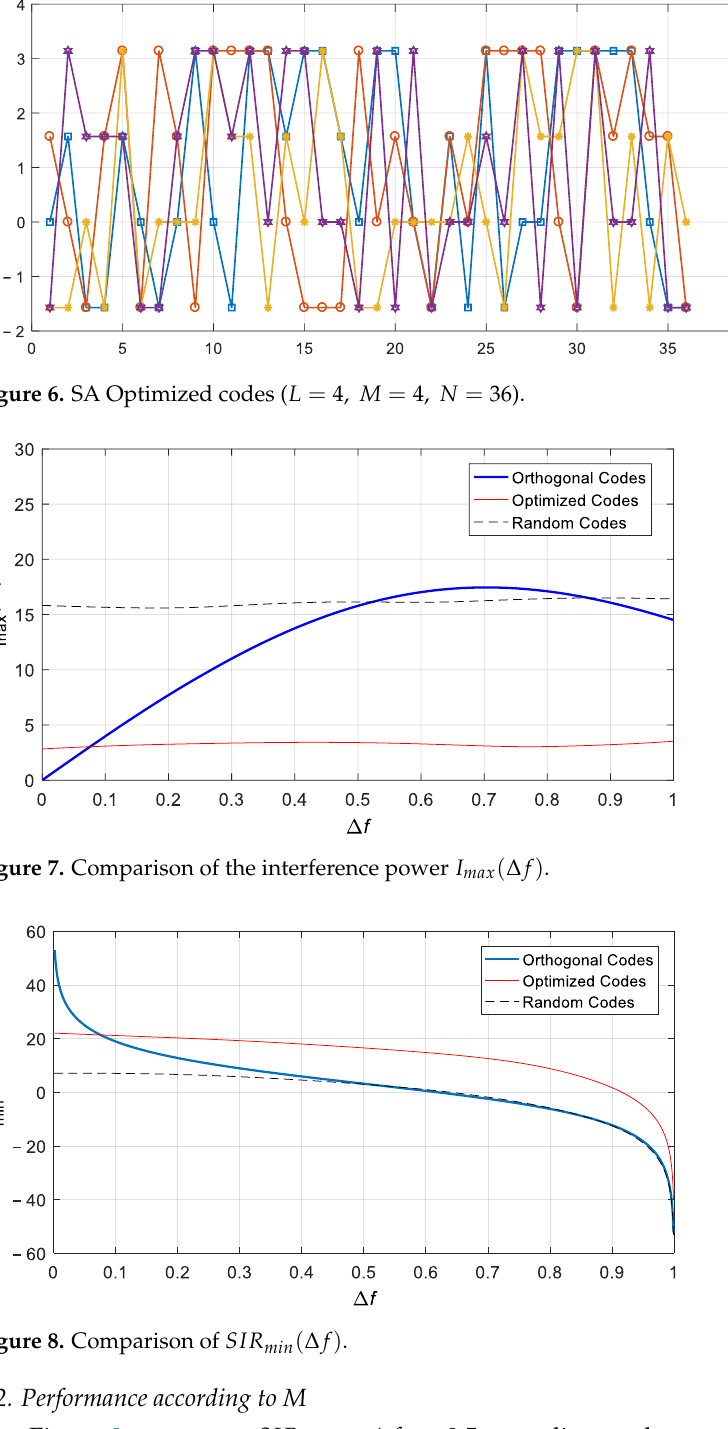
Figure 8. Comparison of 𝑆𝐼𝑅 𝑚𝑖𝑛 (Δ𝑓) .